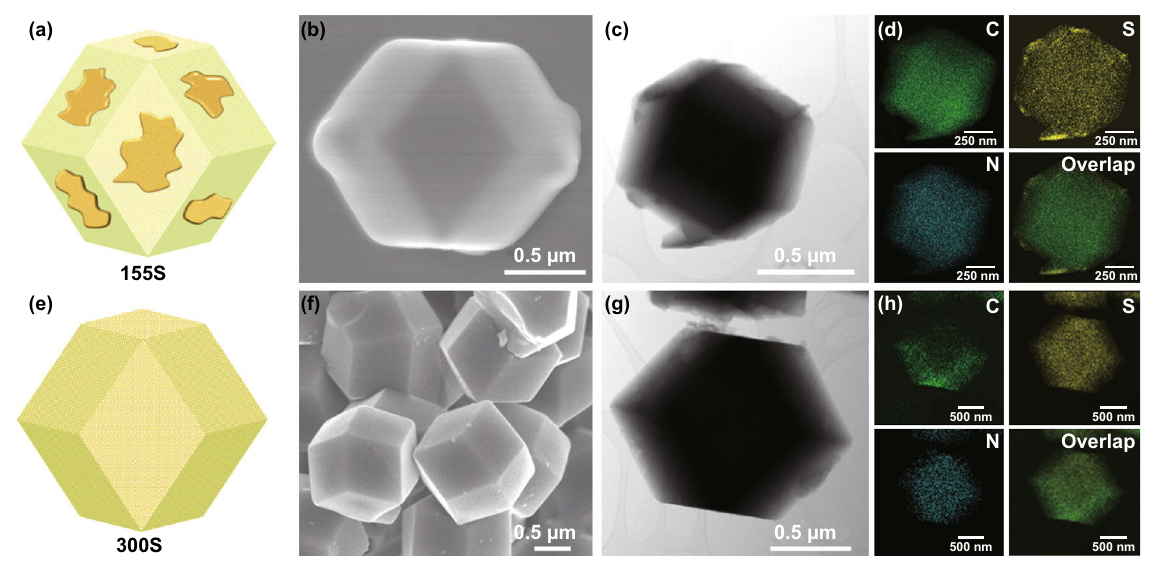
Fig. 1 a Schematic illustration of the 155S. b SEM image of the 155S. c STEM image of the 155S. d EDS mappings of the 155S. e Schematic illustration of the 300S. f SEM image of the 300S. g STEM image of the 300S. h EDS mappings of the